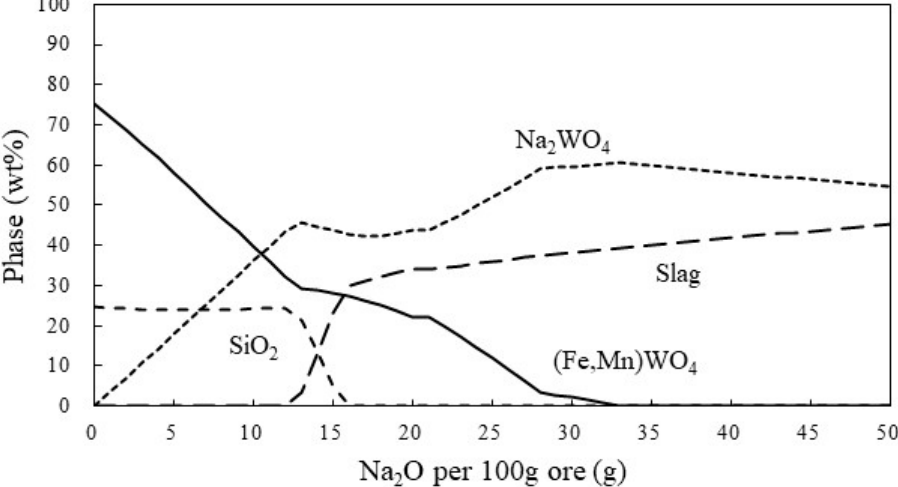
Figure 1. Changes of the phases with the increase in Na 2 O content in air at 1200 ◦ C with 30% SiO 2 , calculated by FactSage 8.2.